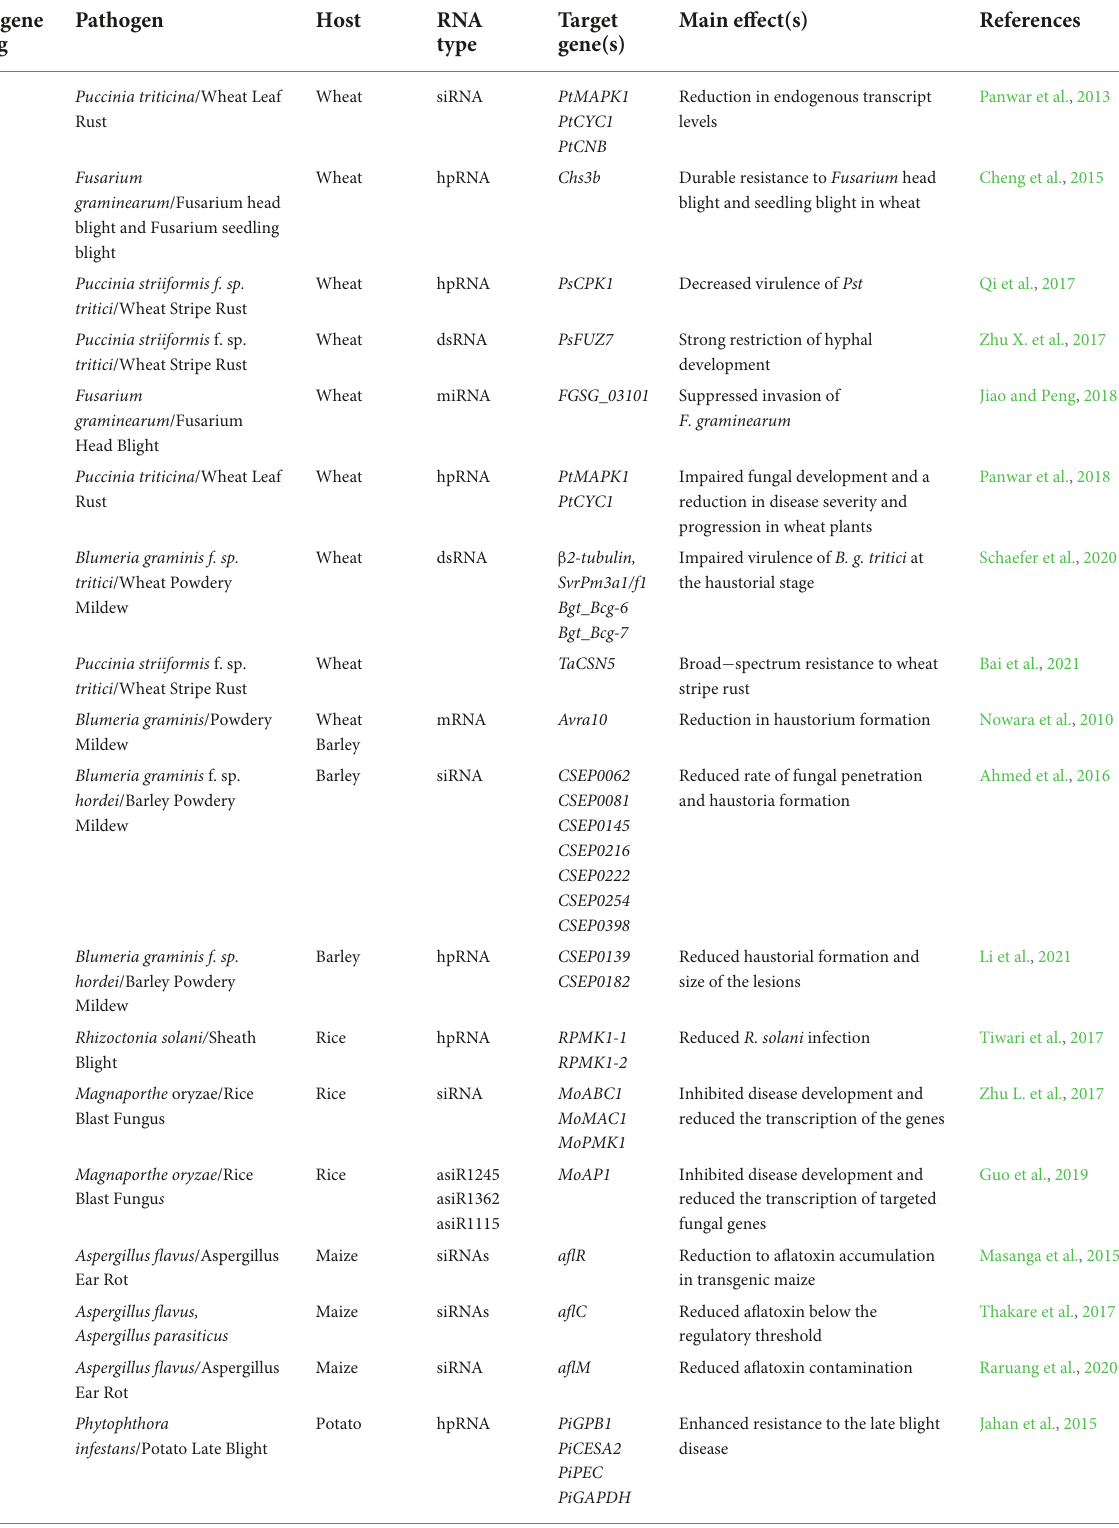
TABLE 3 Summary of HIGS and SIGS applications for control of fungal and oomycete